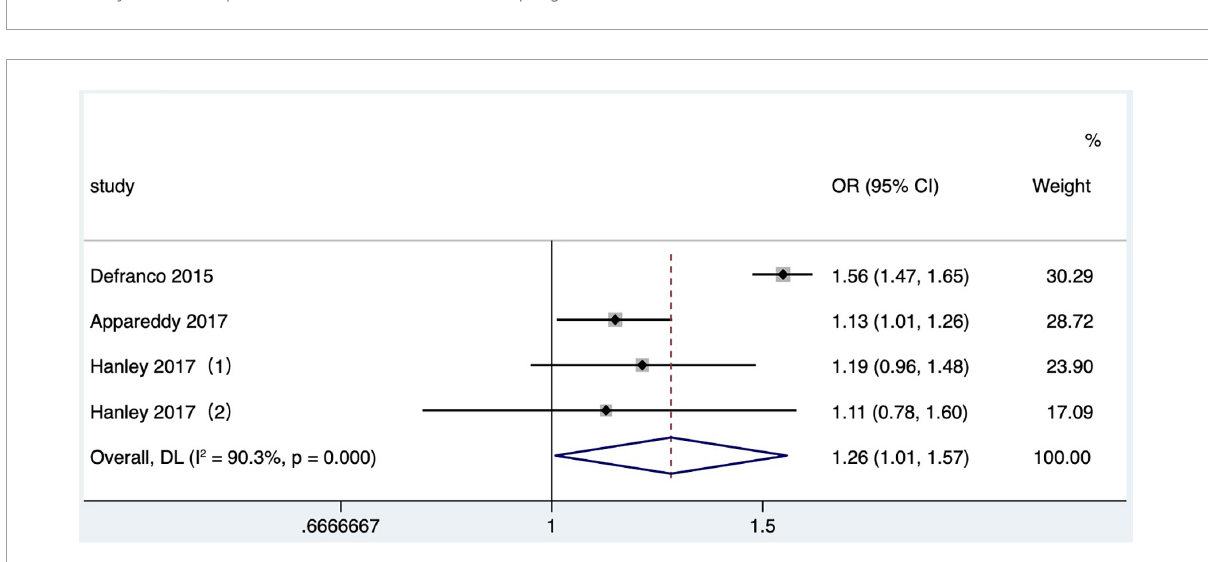
FIGURE7 Meta-analysis forest map of the influence of short IPI on NICU. Hanley et al. (36) (1) was non-matching data, and Hanley et al. (36) (2) was within-mother matching